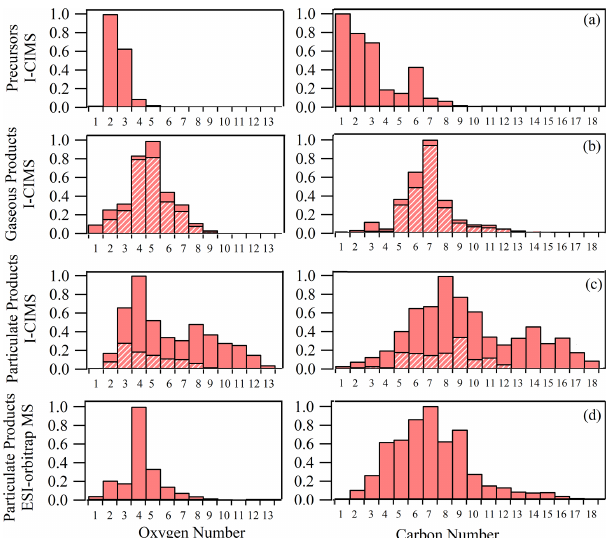
Figure 3. Oxygen and carbon atom number distributions of poten- tial VOC precursors (a) , gaseous products (b) and particulate prod- ucts measured by the iodide-CIMS (c) , as well as the particulate products measured by ESI-orbitrap MS (d) in a typical ozonolysis experiment (dynamic mode). Hatched bars indicate the fractions of organic formulas observed in both gas and particle phases by the iodide-CIMS.